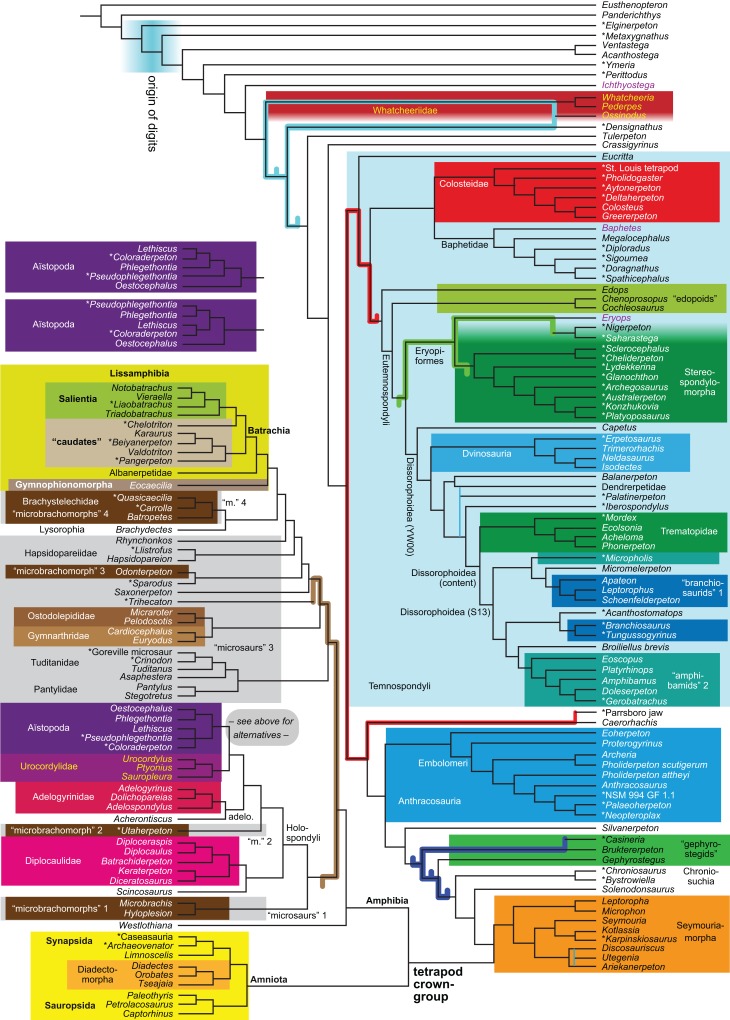
Representation of all MPTs (length: 3,011 steps) from Analysis R4 (revised matrix, expanded taxon sample, no constraint).The insets at the left show the two remaining parsimonious alternatives to the three aïstopod topologies shown in the main tree. In this and the following figures, the names Stereospondylomorpha and Limnarchia are placed according to prevailing usage, not according to the definitions by Yates & Warren (2000) or Schoch (2013). According to the definition by Yates & Warren (2000), Stereospondylomorpha would in this analysis probably exclude *Sclerocephalus and *Cheliderpeton, possibly also *Glanochthon; all three were included in the different topology of Yates & Warren (2000: fig. 1). Limnarchia would be a synonym of Stereospondylomorpha as used here, but would exclude the originally included dvinosaurs. Stereospondylomorpha as redefined by Schoch (2013) would have the contents shown here, but this does not apply to some of the following figures. Similarly, Dvinosauria would under its original definition (Yates & Warren, 2000) be a synonym of Dissorophoidea as defined in the same work; as redefined by Schoch (2013), it would have the contents shown here, but not quite in Fig. 16. The teal underlay connects the four positions of Ossinodus (a whatcheeriid sister to the rest, one node more crownward than Whatcheeriidae, sister to *Densignathus, or one node more crownward than it). The two positions of the “Parrsboro jaw” (see text) are connected by the red underlay. The green underlay connects the two positions of (*Nigerpeton + *Saharastega), the dark blue one the four of *Casineria, the brown one the two of *Trihecaton.